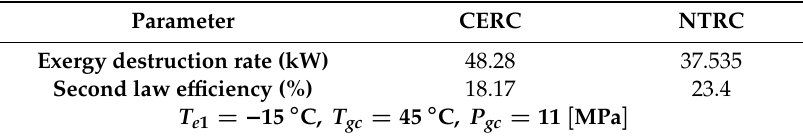
Table 9. CERC and NTRC exergy destruction and e ffi ciency.